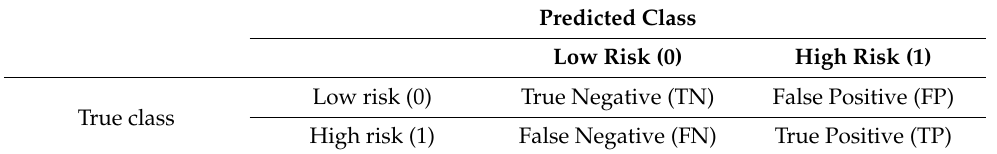
Table 6. Confusion Matrix.